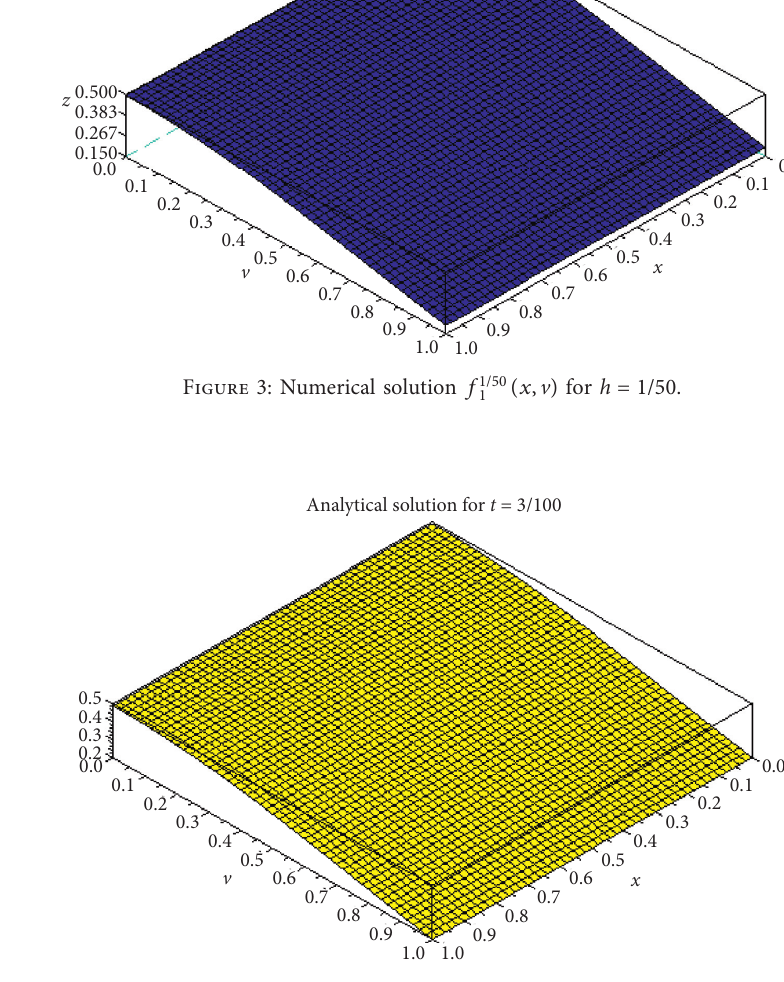
Figure 4: Analytical solution f ( 3/100 , x, v ) for h � 1/50 and t � 3/100 ∈ [ 1/50 , 1/25 )